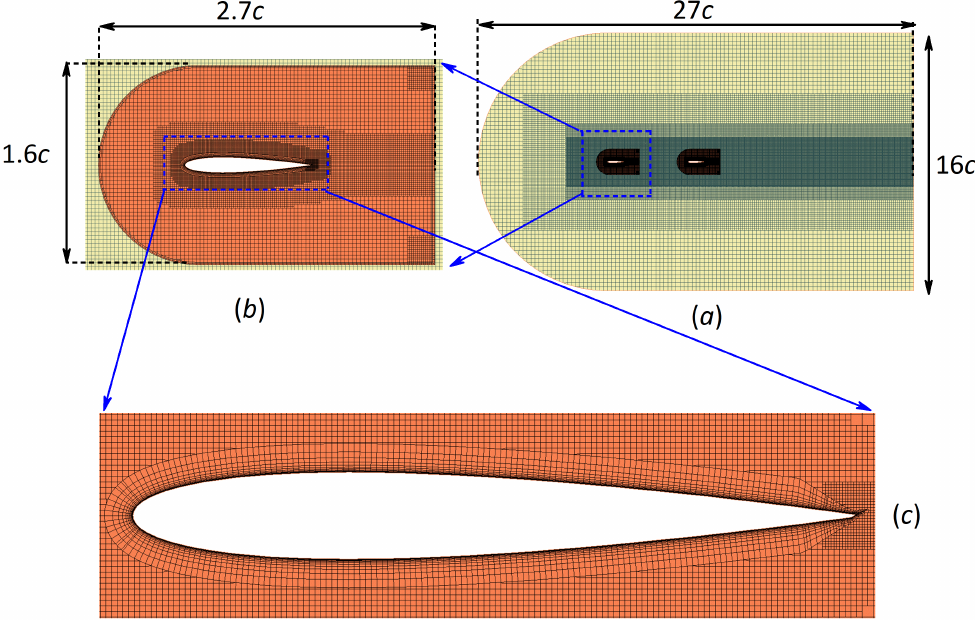
Figure 4. Computational domain and mesh structures of two NACA0012 hydrofoils in tandem configuration. ( a ) Grid of the computational domain with boundaries. ( b ) Close-up view of Grid around overset mesh. ( c ) Close-up view of grid around the hydrofoil.